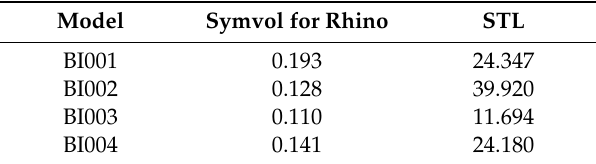
Table 2. File sizes of the models in various formats are given in MB.